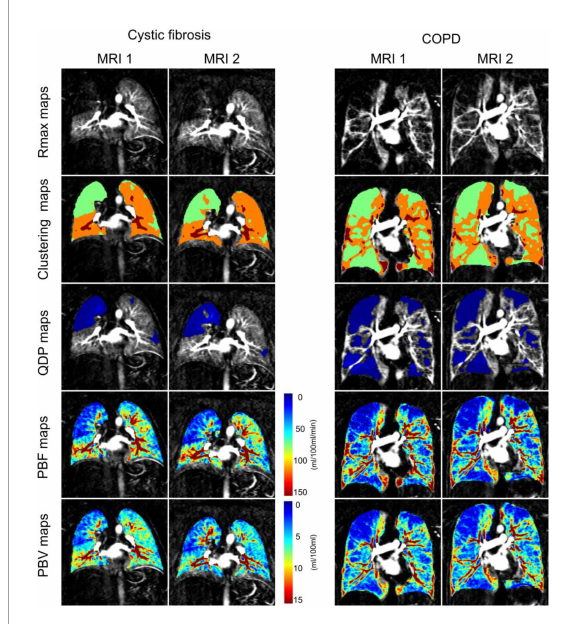
FIGURE1 Coronal residue function maps at the time point of maximum contrast-enhancement in the whole lung (Rmax maps), corresponding clustering maps for perfusion defects in percent maps (QDP maps) computation (3 clusters from 2 thresholds determined with Otsu’s method), QDP maps (defects highlighted in blue) and pulmonary blood flow maps (PBF maps) and pulmonary blood volume maps (PBV maps) from a representative cystic fibrosis and chronic obstructive pulmonary disease (COPD) patient at baseline (MRI1) and 1 month follow-up (MRI2). QDP was 21.57% at MRI1 and 20.61% at MRI2 in the cystic fibrosis patient, and 42.96% at MRI1 and 43.56% at MRI2 in the COPD patient (highlighted in blue). Perfusion scores were 8 at MRI1 and 7 at MRI2 for the cystic fibrosis patient, and 12 at MRI1 and 12 at MRI2 for the COPD